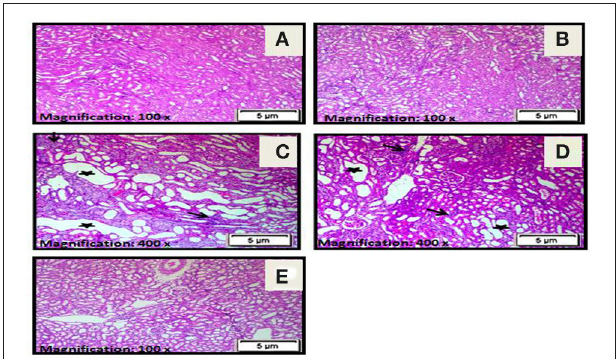
FIGURE 3 | (A) A photomicrograph of the section from the cortex of the rats in the control normal first group revealed a normal histology of kidney tissue. (B) A photomicrograph of the section from the cortex of rats in the stem cell second group showed a normal histology of the kidney cortex. (C) Photomicrographs of sections from the cortex of rats in the diseased third group demonstrated marked tubular necrosis with markedly dilated irregular proximal tubules with attenuation or loss of lining epithelial cells (star) and interstitial mononuclear inflammatory cell infiltration (arrow). (D) Photomicrographs of sections from the cortex of rats in the preventive fourth group showed moderate tubular necrosis with dilated irregular proximal tubules and attenuation or loss of lining epithelial cells (star) together with interstitial mononuclear inflammatory cells infiltration (arrow). (E) A photomicrograph of the section from the cortex in the treated fifth group rats showed resolution of all histopathological alterations with tubular regeneration and resolution of interstitial inflammatory infiltrate (H&E ×